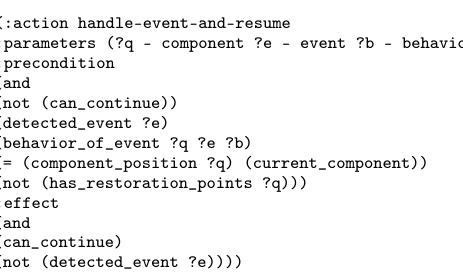
Figure 6. Example of domain action to recover from an interruption of the nominal flow.